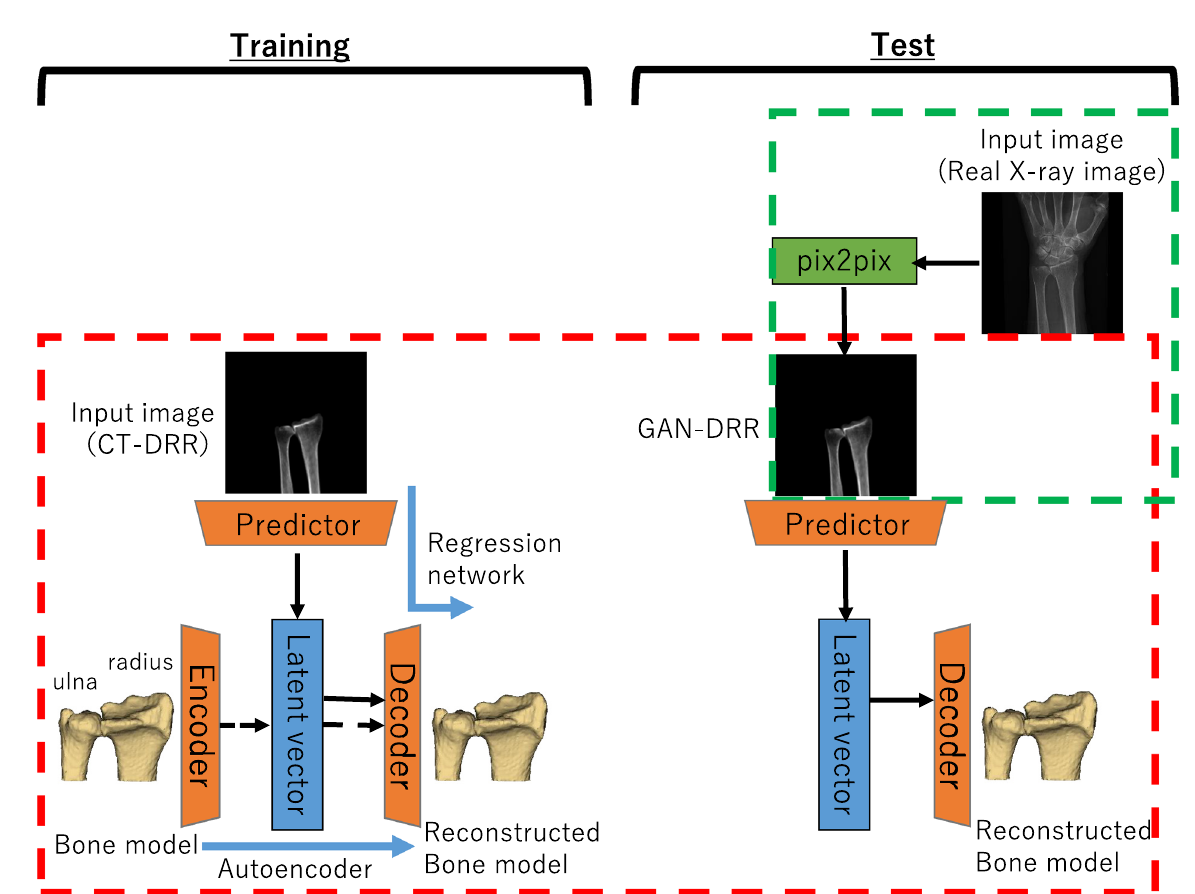
Figure 1. Flow chart of the proposed 2D–3D reconstruction method. The left half denotes training; the right half denotes test. Red frame: CNNs (TL net). Green frame: GAN